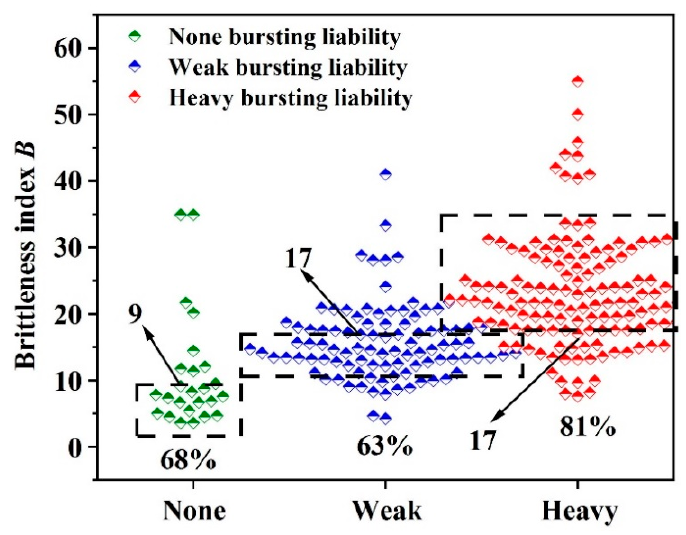
Figure 10. Bee colony map of the brittleness index B.